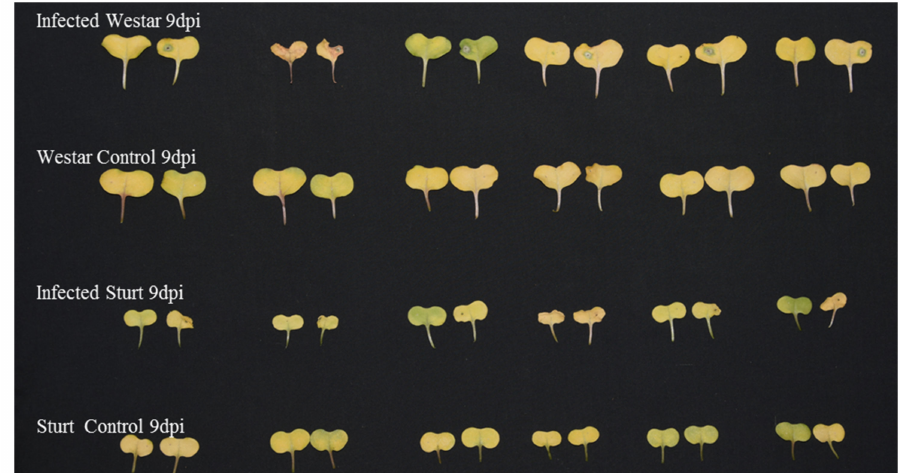
Figure 1. Necrotic lesions caused by Leptosphaeria maculans 9 days after inoculation at the seedling stage of Brassica napus . Susceptible cultivar: Westar, Resistant cultivar: